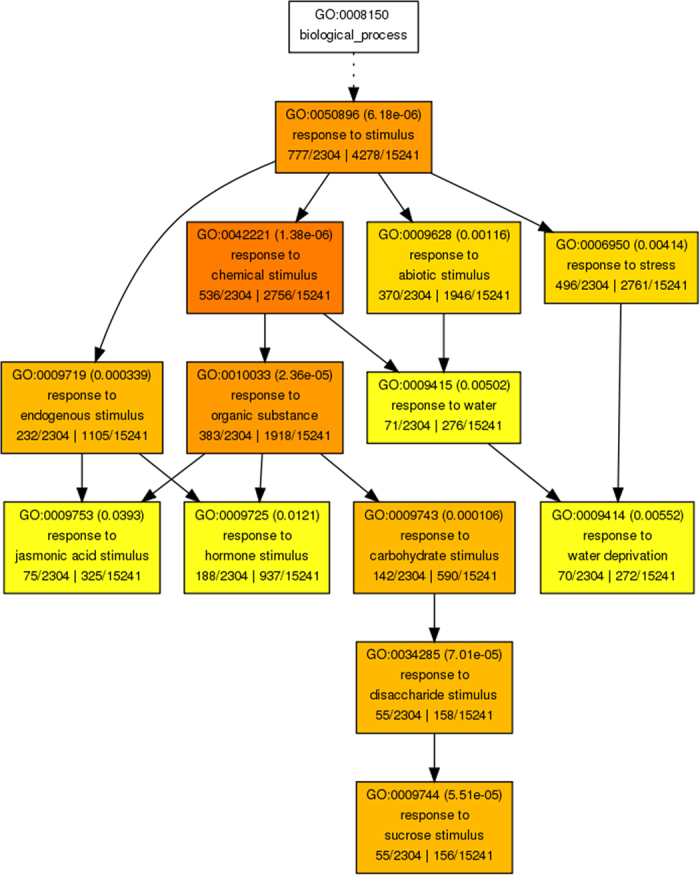
Agri GO analysis of DEGs in leaves.Statistical standards are as in Fig. 6.